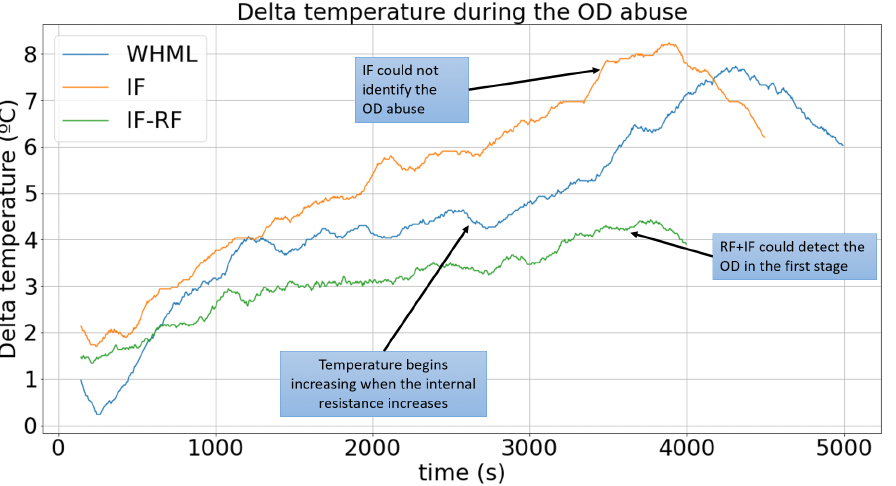
Figure 15. The behavior of the delta temperature under the OD abuse experiments without ML and with the IF and RF. As the combination of the IF-RF could identify the OD abuse before the failure, the time of the abuse is shorter than the other